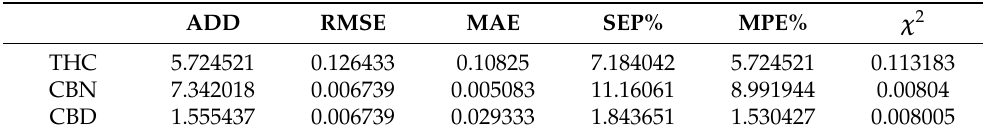
Table 7. Statistical errors determined for each response. ADD